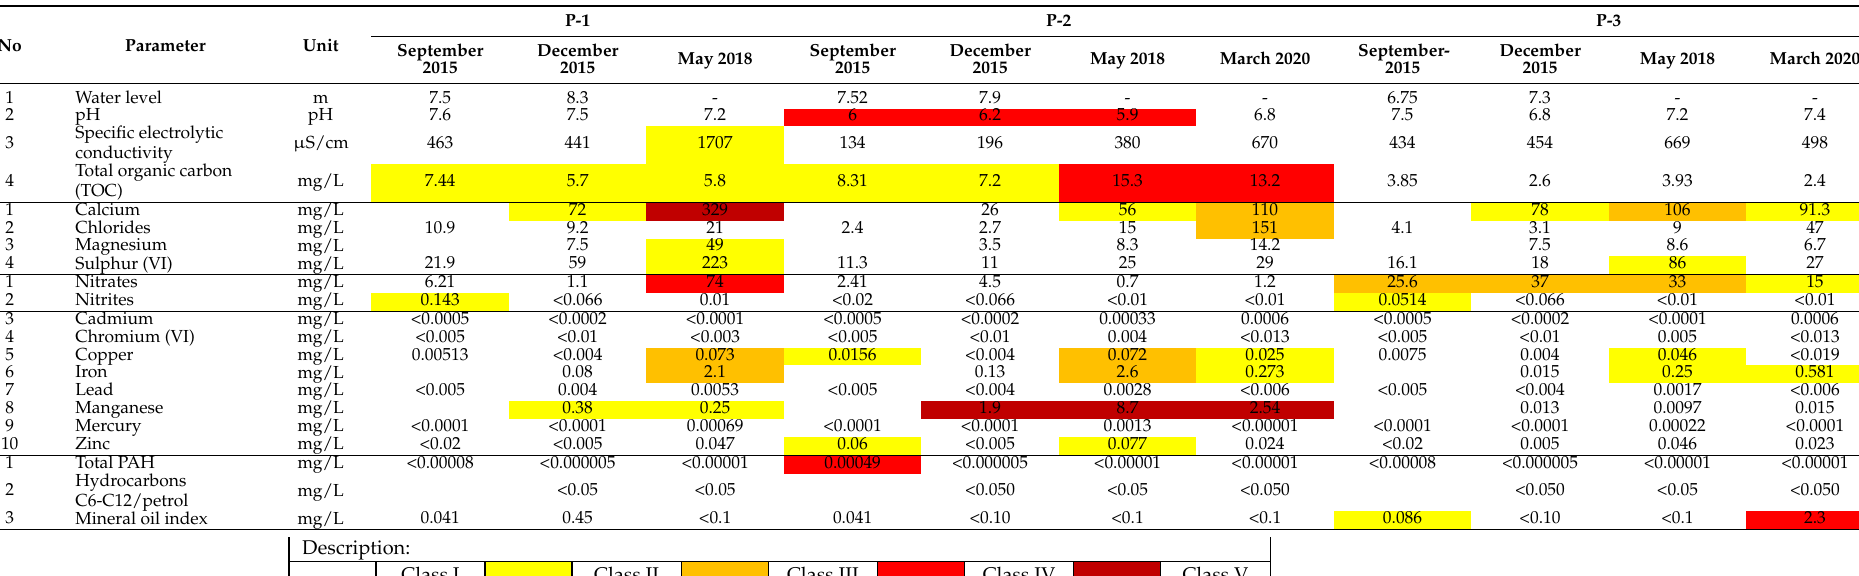
Table 3. A change in the physico-chemical characteristics of groundwater during the operation of the ZUOK in Olsztyn between September 2015 and March